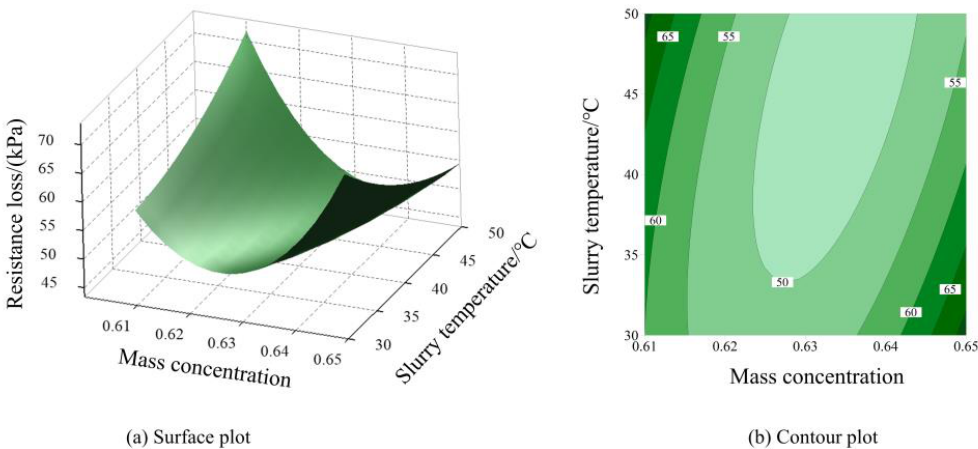
Figure 9. Interaction of mass concentration and slurry temperature with resistance loss: the other factor is held at the center level.